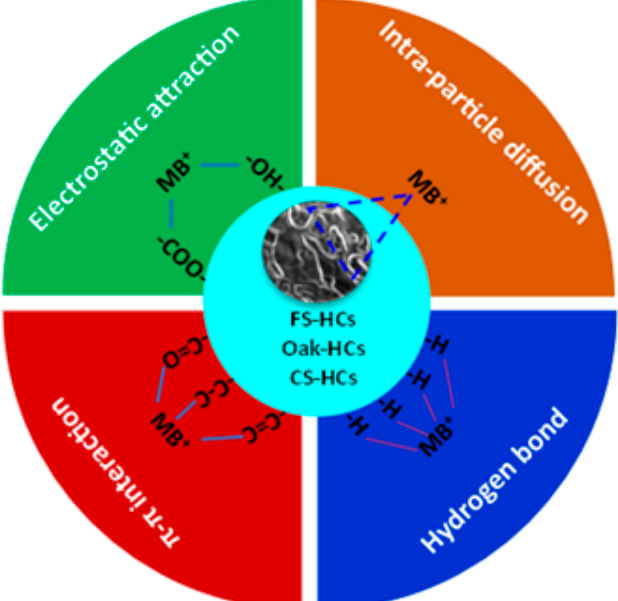
Figure 6 . Proposed chemical pathways involved in the removal mechanism of MB onto the hy- Figure 6. Proposed chemical pathways involved in the removal mechanism of MB onto the drochars.